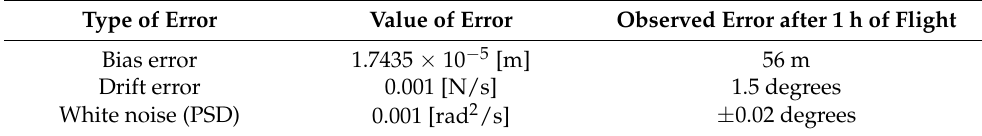
Table 1. Summary of the results from Figures